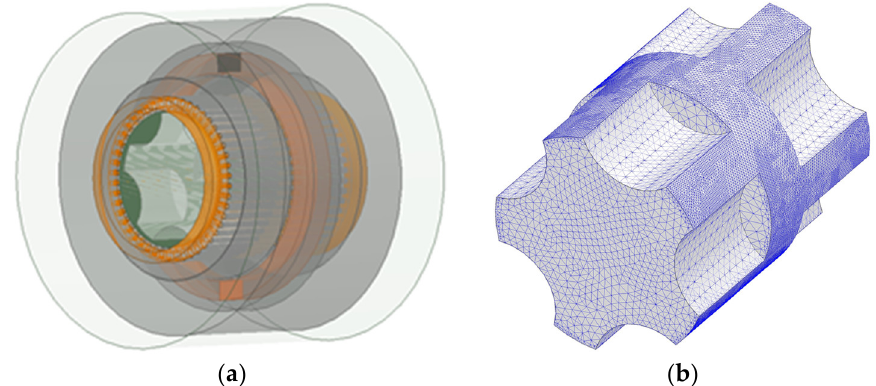
Figure 12. Three-dimensional FEM of the HTR-ASD. ( a ) The FEM model of the HTR-ASD. ( b ) Mesh of the rotor finite element model.